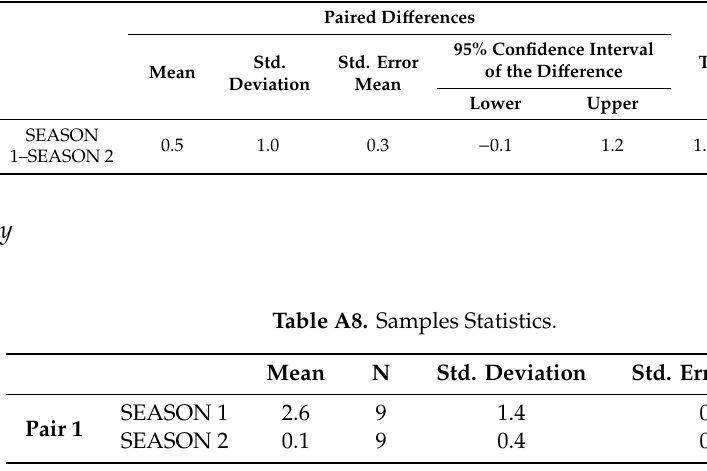
Table A7. Samples